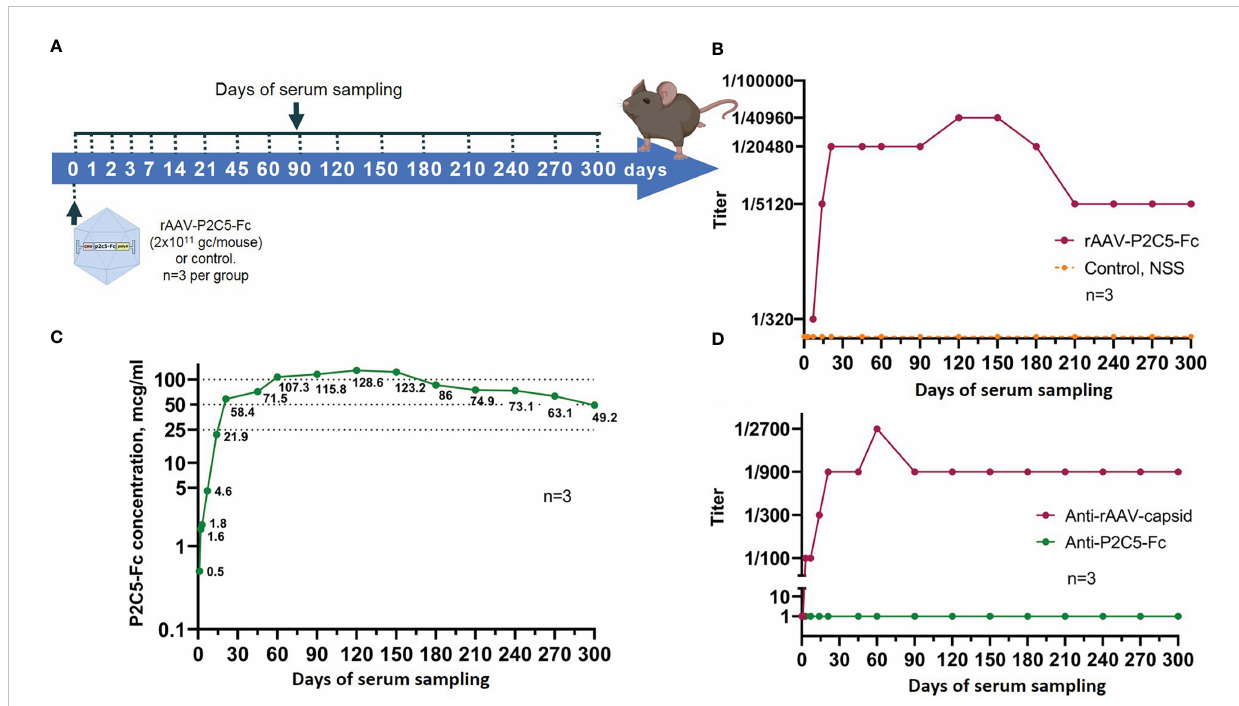
FIGURE 8 Evaluation of blood serum samples collected from mice treated with rAAV-P2C5-Fc. (A) Scheme of the experiment: a single intramuscular injection of rAAV-P2C5-Fc at a dose of 2*10 11 gc/mouse was performed. Serum samples were taken at days 0, 1, 2, 3, 7, 14, 21, 45, 60, 90, 120, 150, 180, 210, 240, 270, and 300 after the injection; (B) Titers of virus-neutralizing antibodies to SARS-CoV-2 B.1.1.1 variant, (C) Levels of P2C5-F с antibody and (D) Titers of rAAV- and P2C5-Fc-speci fi c antibodies in blood serum of the animals. Lines – mean values, n – number of animals per